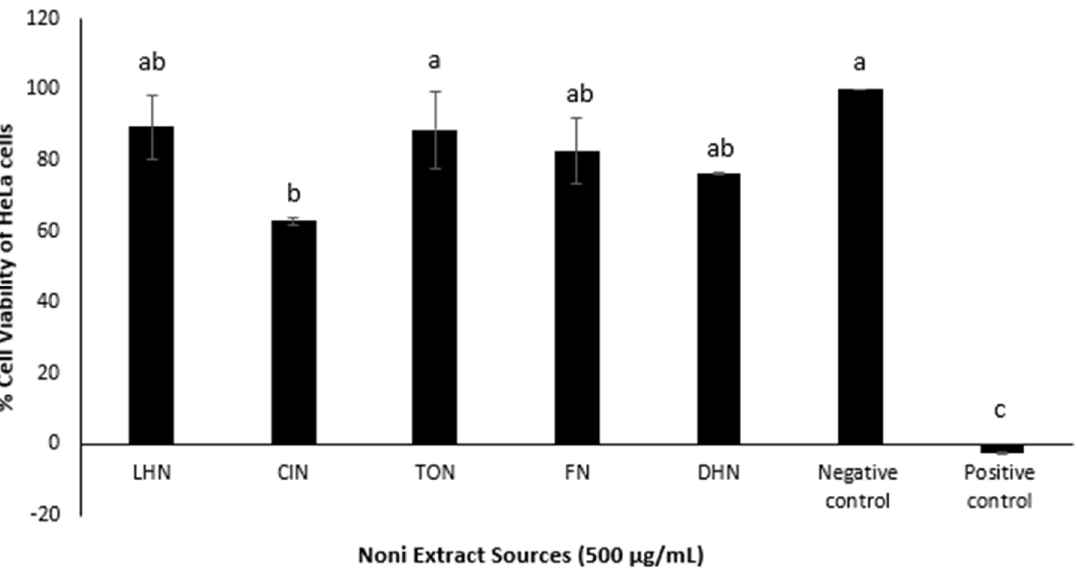
Figure 3. The percentage cell viability of HeLa cells treated with different sources of Noni juice extracts at 500 µg/mL. Different letters on the bar indicate significant difference between the different sources of Noni crude extracts ( p < 0.05). Negative control: cells without treatment; positive control: cells treated with 10 µg/mL cisplatin (chemotherapy drug). Abbreviations: FN = Fijian Noni; LHN = Life Health Noni; DHN = Dynamic Health Noni; TON = Tahitian Organic Noni; CIN = Cook Island Noni.